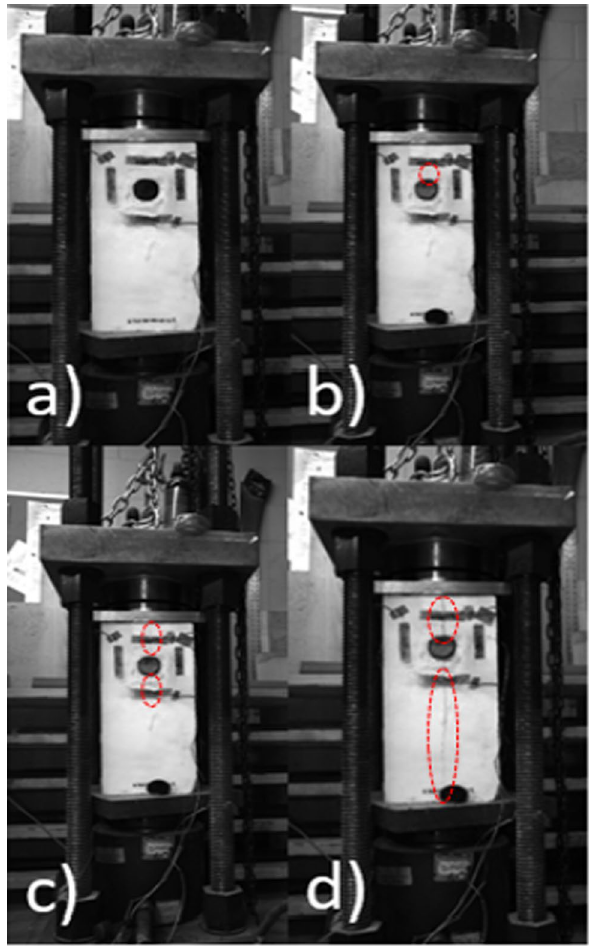
Fig. 17 G-SL2-150-600-UT-L a At time t t 7.5 d Complete breakage at